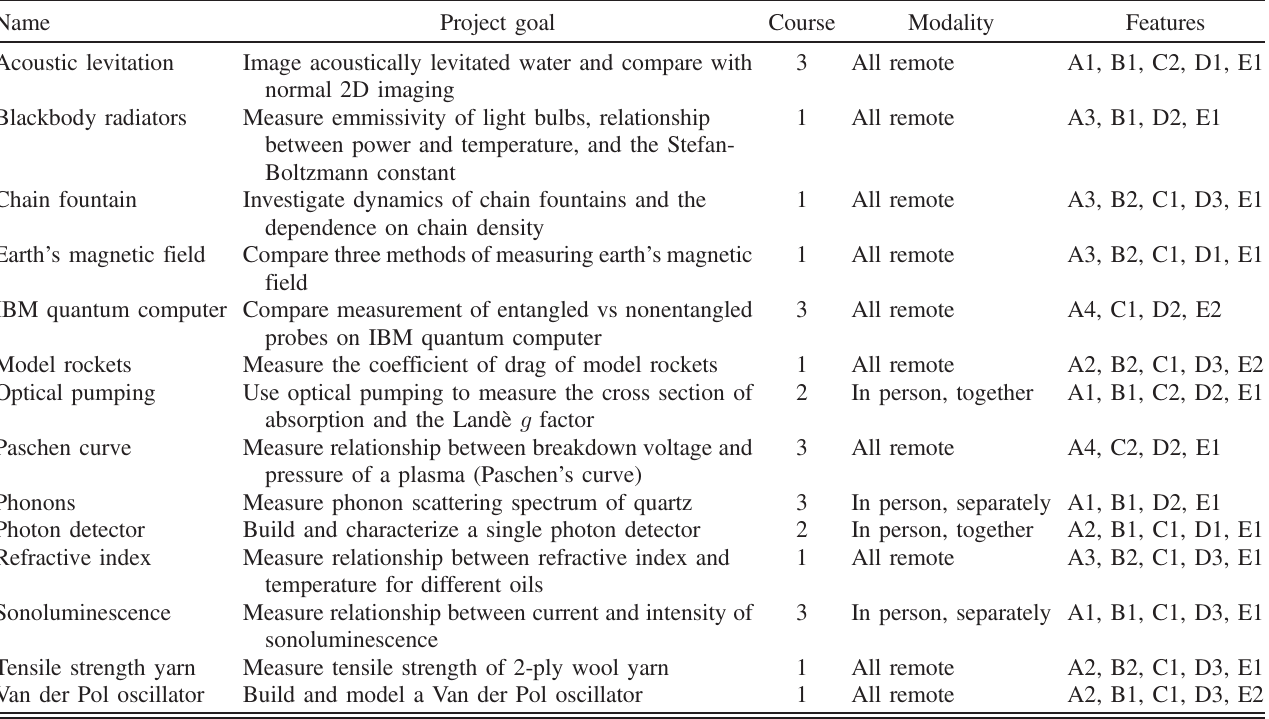
TABLE III. List of the 14 student-designed projects. The names are used as project identifiers in Figs. 3 and 5. The modality denotes whether all the students on each project worked remotely, went in to the lab at the same time, or went into the lab at different times from one another in order to satisfy social distancing protocols. The feature labels are defined in Sec.